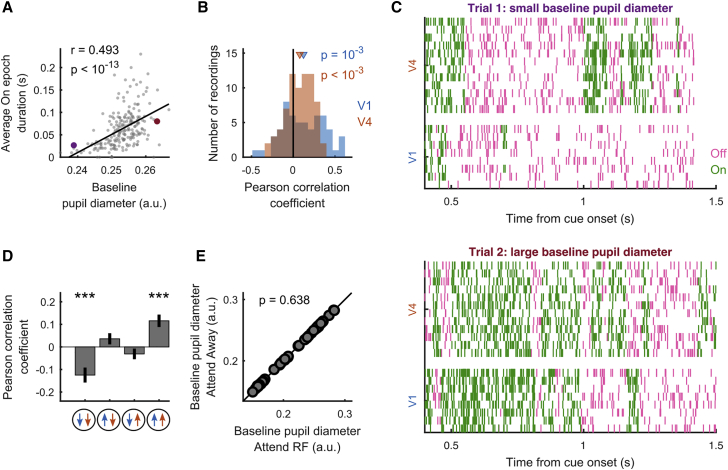
The relationship between baseline pupil diameter and On/Off episode durations(A) Example recording showing that baseline pupil diameter is positively correlated to the average On episode duration in V1. Each dot represents a single trial; r is the Pearson correlation coefficient. The purple and red dots indicate the example trials used in (C).(B) Across recordings, the average duration of On epochs in both V1 and V4 is positively correlated with the size of the baseline pupil diameter.(C) MUA raster plot of 2 example trials in which the average On epoch duration is longer on the trial with larger (bottom) compared to the trial with smaller (top) baseline pupil diameter.(D) Across recordings, baseline pupil diameter is negatively (positively) correlated with the average epoch duration when both V1 and V4 are in an Off (On) phase.(E) The average baseline pupil diameter during attend RF conditions plotted against attend away conditions. There is no difference between attention conditions. Each dot represents a recording session.Statistics: two-sided Wilcoxon signed rank test (FDR corrected) (B, D, and E) and Pearson correlation (A). Data are represented as means ± SEMs across recordings; significance levels ∗p < 0.05, ∗∗p < 0.01, and ∗∗∗p < 0.001.